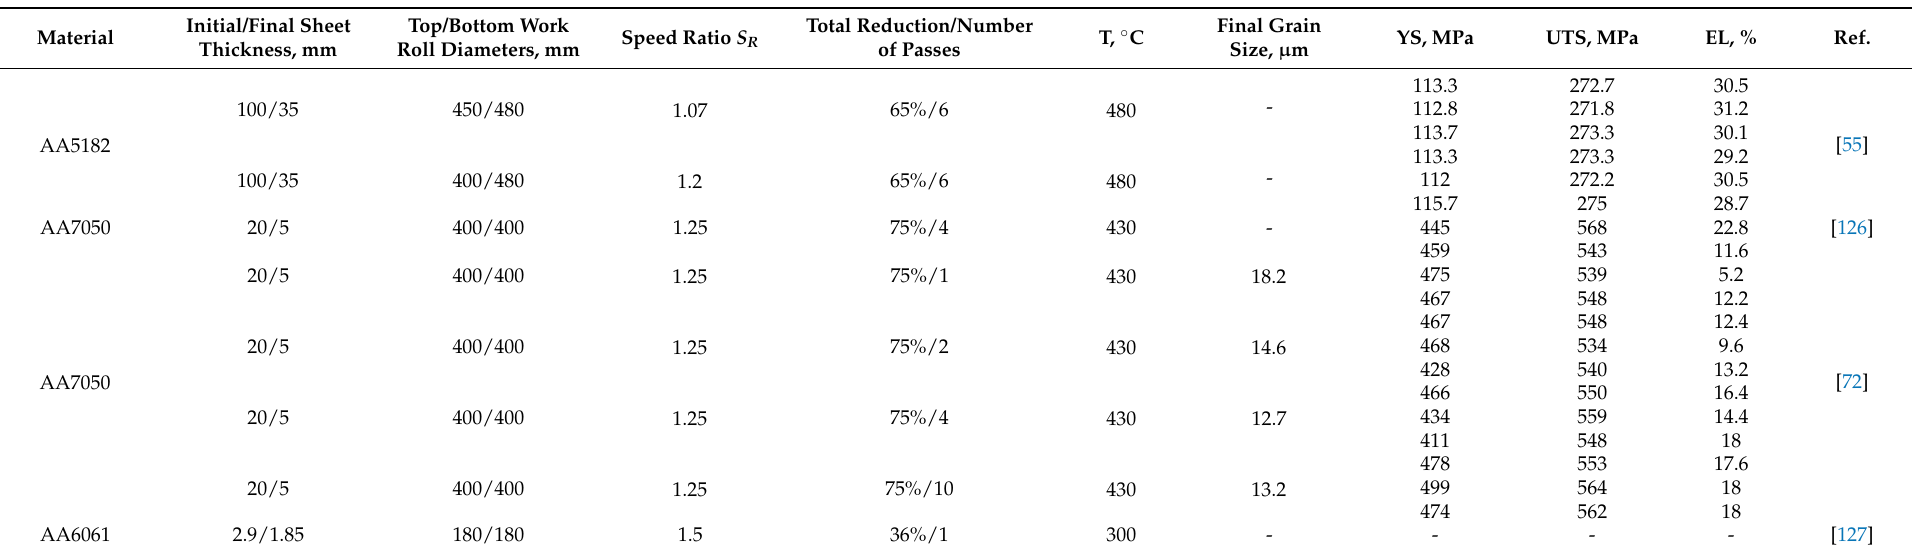
Table 5. Experimental data related to asymmetric hot rolling of Al alloys.